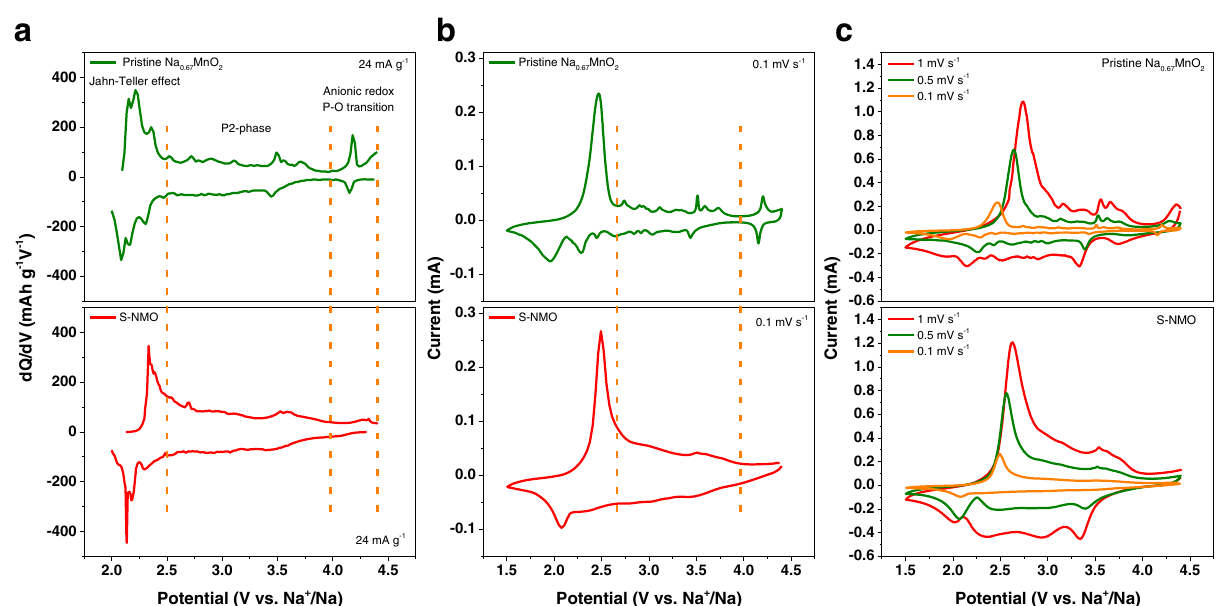
Fig. 4 Redox behavior of pristine Na 0.67 MnO 2 and S-NMO. a dQ/dV pro fi les within 2.0 – 4.4 V obtained from galvanostatic curves at 24 mA g − 1 . b CV curves at 0.1 mV s − 1 from 1.5 to 4.4 V. c CV curves at the sweep rates of 0.1, 0.5, and 1 mV s − 1 within 1.5 – 4.4